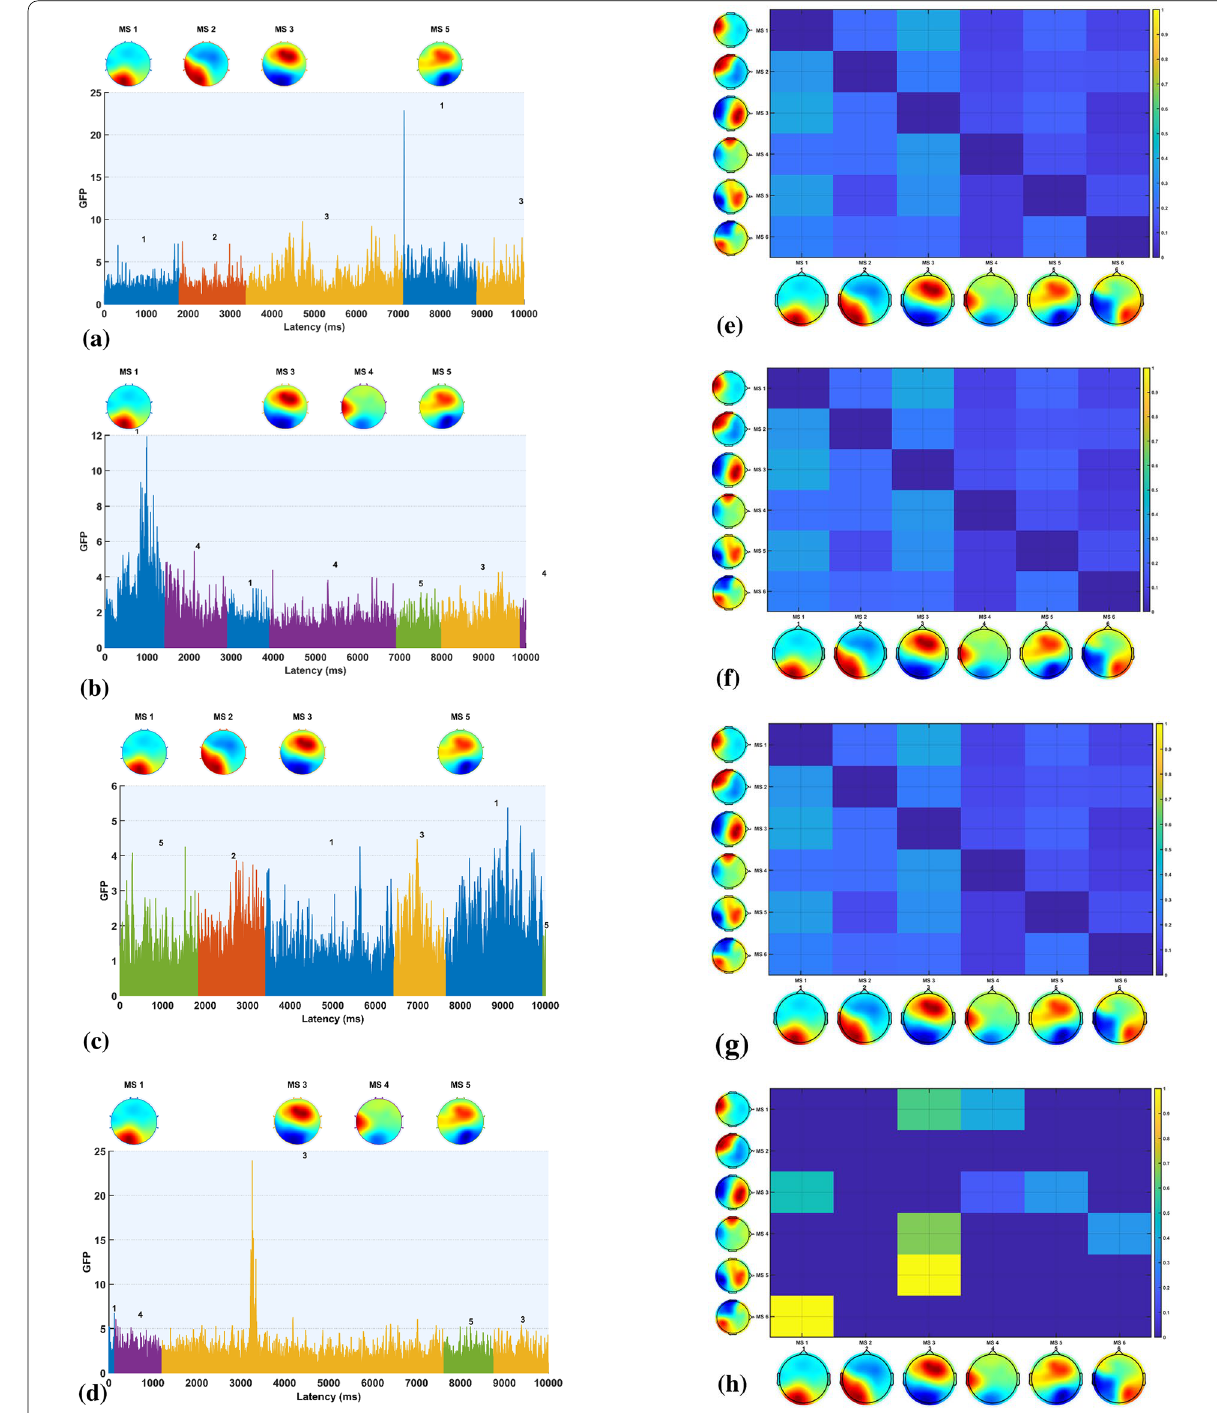
Fig. 5 Illustrative figure of the GFP of active microstates dynamics, ( a ) during 0 to 10,000 ms at the start of the FLS complex task of the EEG of a novice, ( b ) during 0 to 10,000 ms at the start of the FLS complex task of the EEG of an expert, ( c ) during 10,000 ms of the error epoch of the EEG of a novice, ( d ) during 10,000 ms of the error epoch of the EEG of an expert. The statistics on the transition probabilities between microstate (MS) classes at the group level, ( e ) during the 10 s at the start of the FLS complex task in novices, ( f ) during the 10 s at the start of the FLS complex task in experts, ( g ) during the 10 s in the error epoch in novices, ( h ) during the 10 s in the error epoch in experts. In the transition probability matrix, the rows denote the ‘from’ microstate and the columns denote the ‘to’